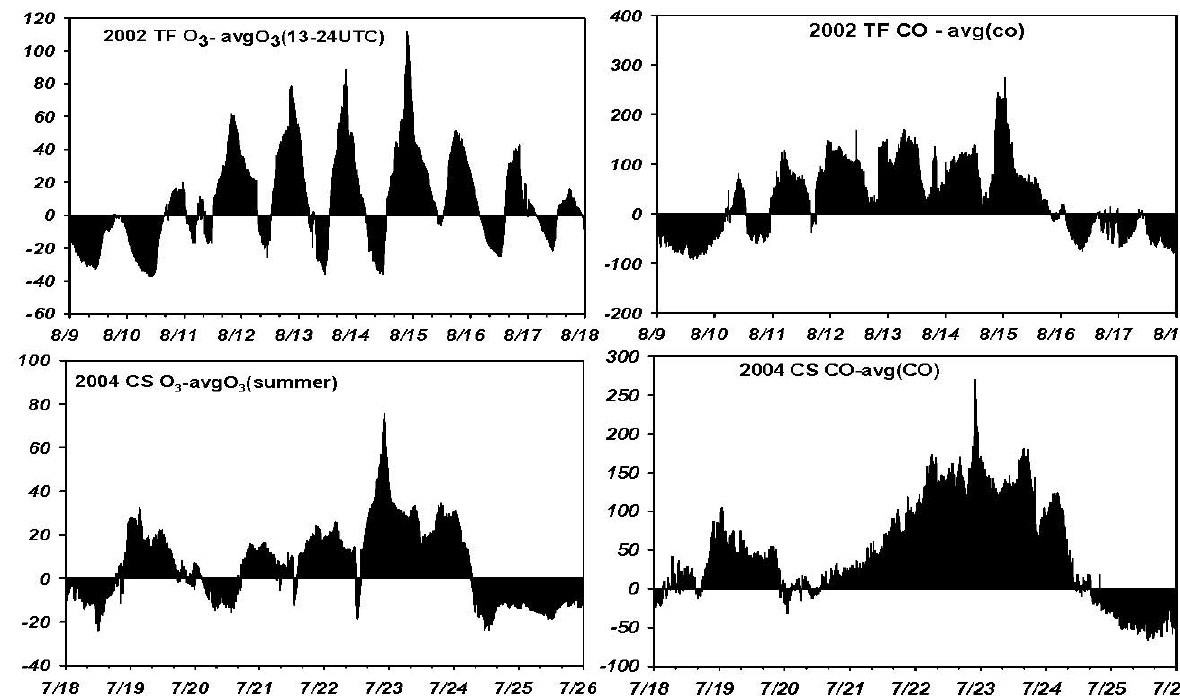
Figure 6. Top: The ΔO3 (left) and ΔCO (right) (Δ = actual observed data minus its summer average) at TF during 9–19 August 2002; Below: The ΔO3 (left) and ΔCO (right) at CS on 18–26 July